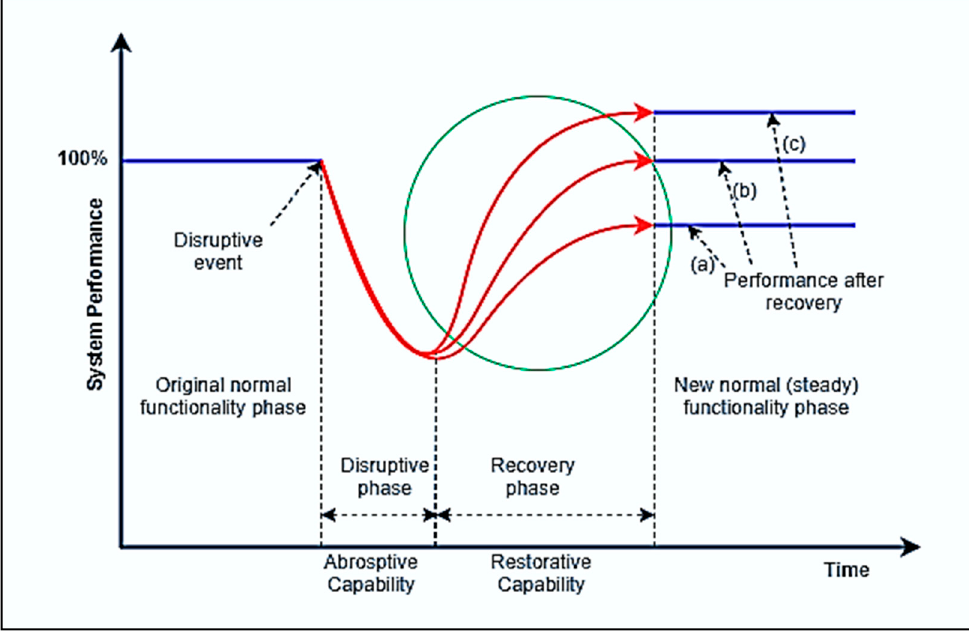
Figure 3. CIS resilience curves, in terms of systems performance or functionality (adapted from References [13,28]).